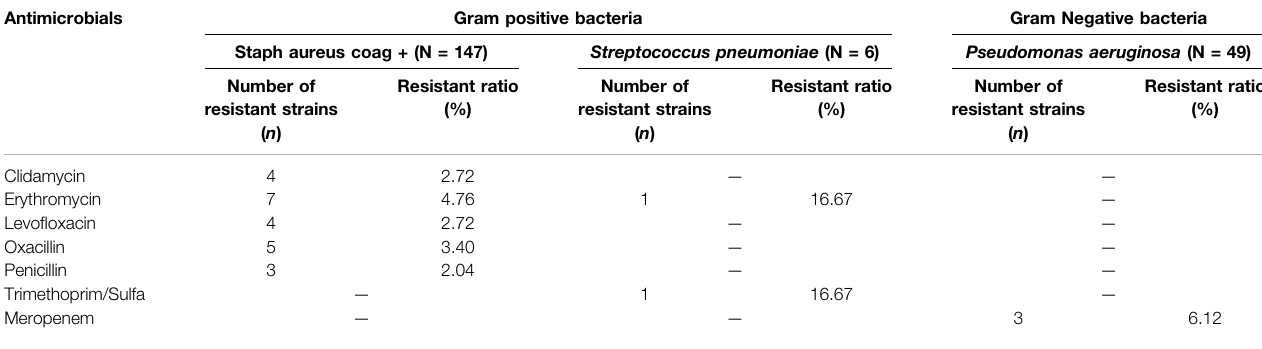
TABLE 4 | Resistance of main Gram bacteria to different antibacterial drugs in respiratory tract specimens of patients with VAP treated with fi rst-generation cephalosporin combined with vancomycin.